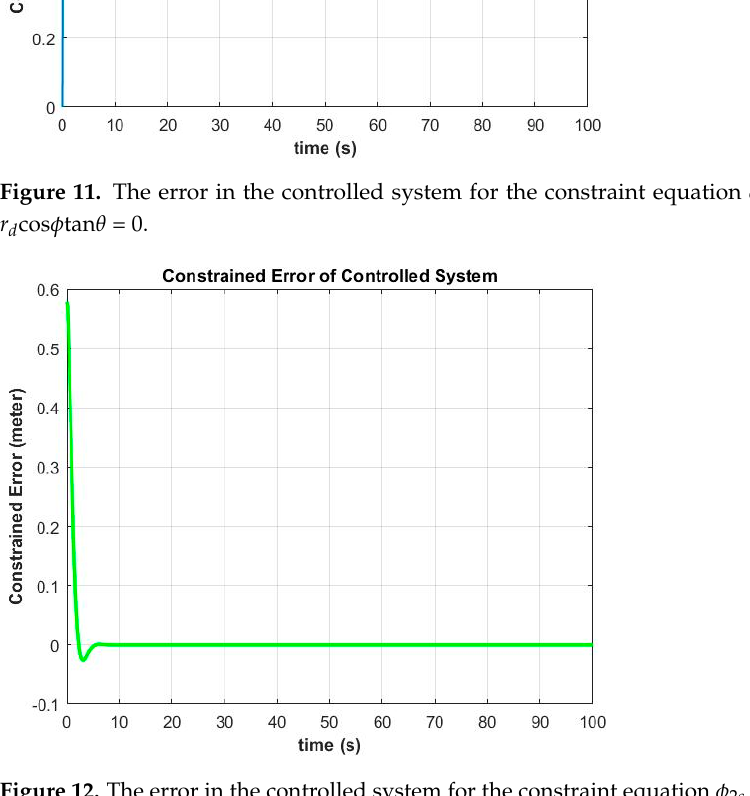
Figure 12. The error in the controlled system for the constraint equation ϕ 2 s = x 2 – y = 0.